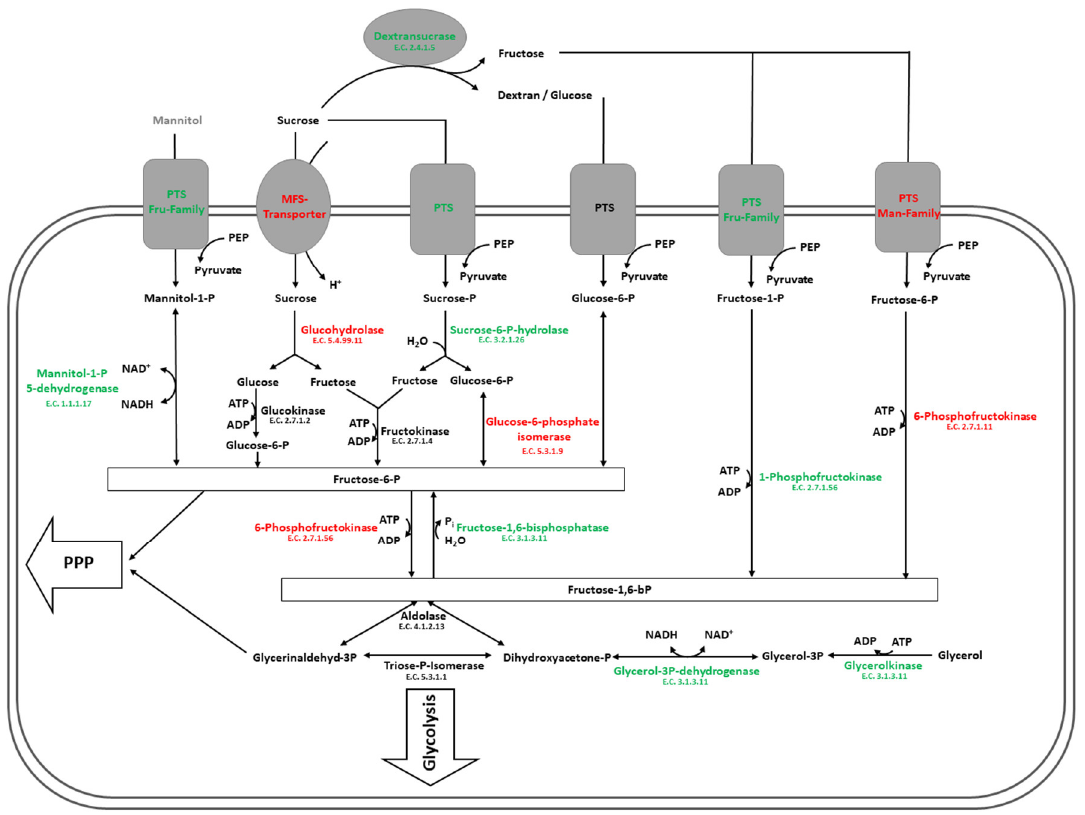
Figure 8. Metabolic pathways as suggested from genomic features and proteomic analysis of cell lysates of cultures incubated in either glucose or sucrose. Green color indicates up-regulation in sucrose, while red color indicates down-regulation in sucrose. PPP = pentose phosphate pathway. Part of this figure is based on Di Xu et al. [36] .